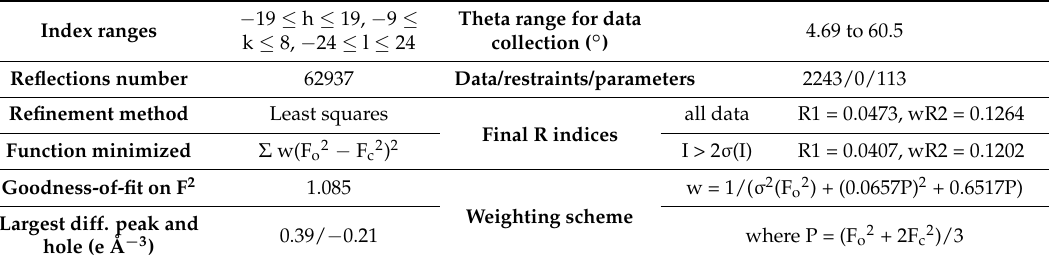
Table 3. Data collection and structure refinement of 1